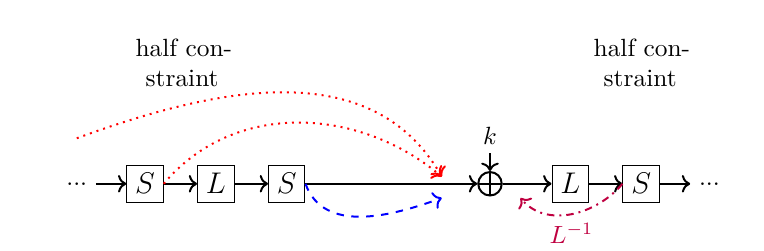
Figure 3: An illustration of how a constraint is formed from using two half constraints. A combination of a red and purple half-constraint forms a nonlinear constraint and a combination of the blue and the purple half-constraint forms a linear